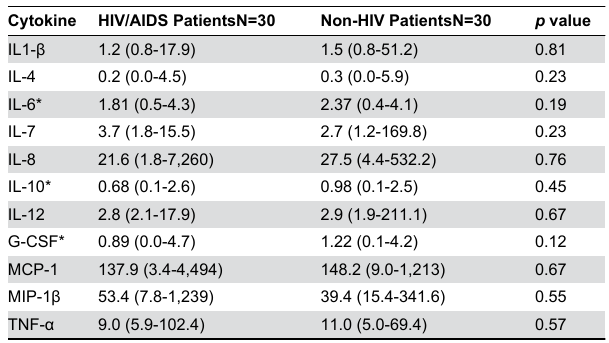
Table 2. Plasma cytokine concentrations on the first day of a sepsis diagnosis in HIV/AIDS and non-HIV septic patients.